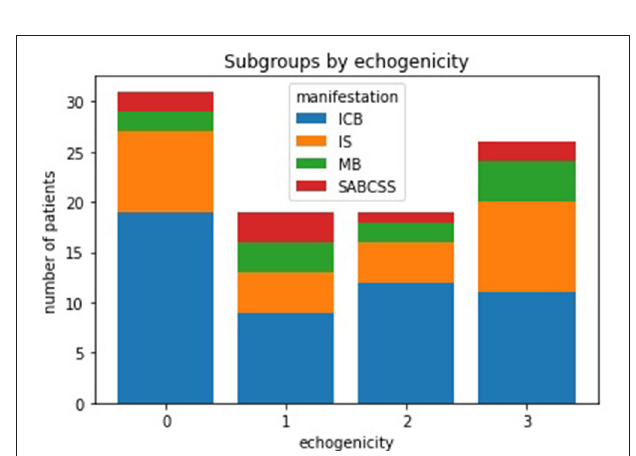
FIGURE 4 | Echogenity of plaques in neurosonographic